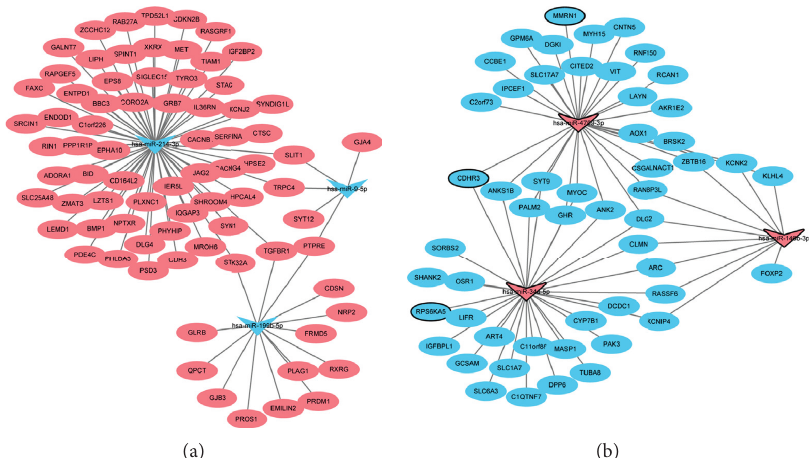
Figure 5: The network of diagnostic miRNA-target mRNAs with negative correlation in PTC based on miRNA-target prediction tools. The rectangle and ellipses represent the diagnostic miRNAs and target mRNAs, respectively; the pink and blue colors represent upregulation and downregulation, respectively; the black border represents the top 10 upregulated and top 10 downregulated